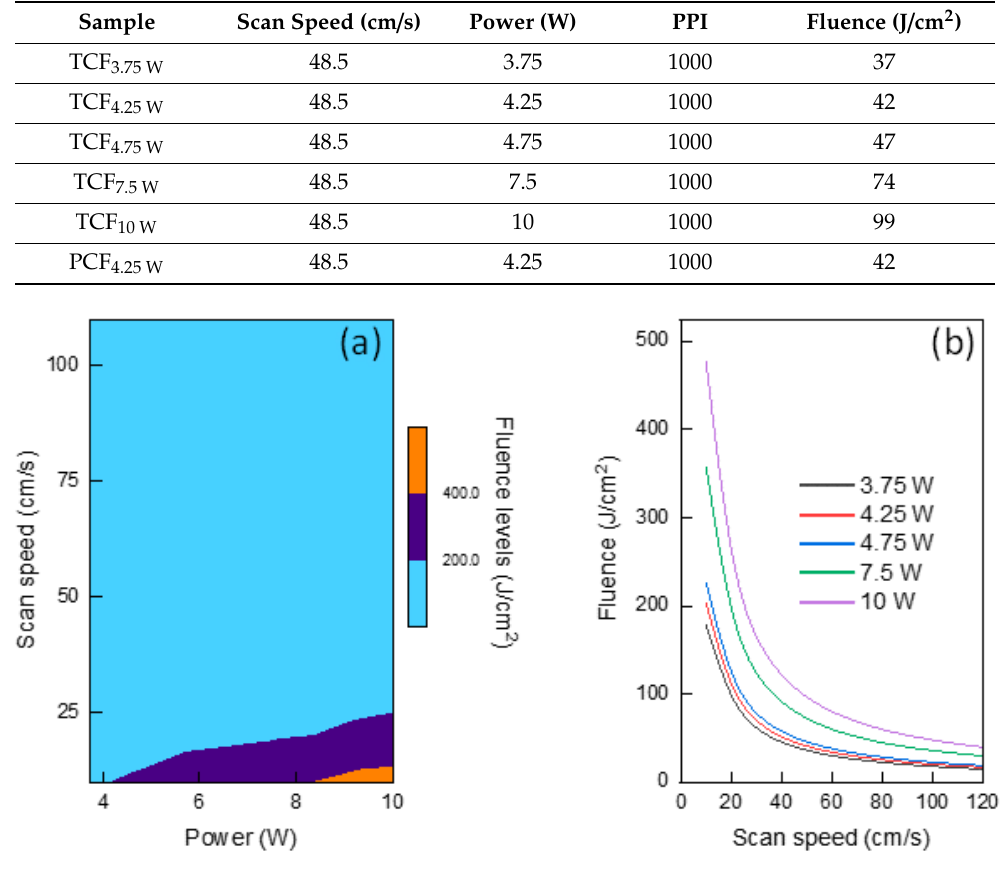
Figure 5. ( a ) Fluence, scan speed, and power correlation contour map. ( b ) Relationship between fluence and scan speed at different laser beam powers.